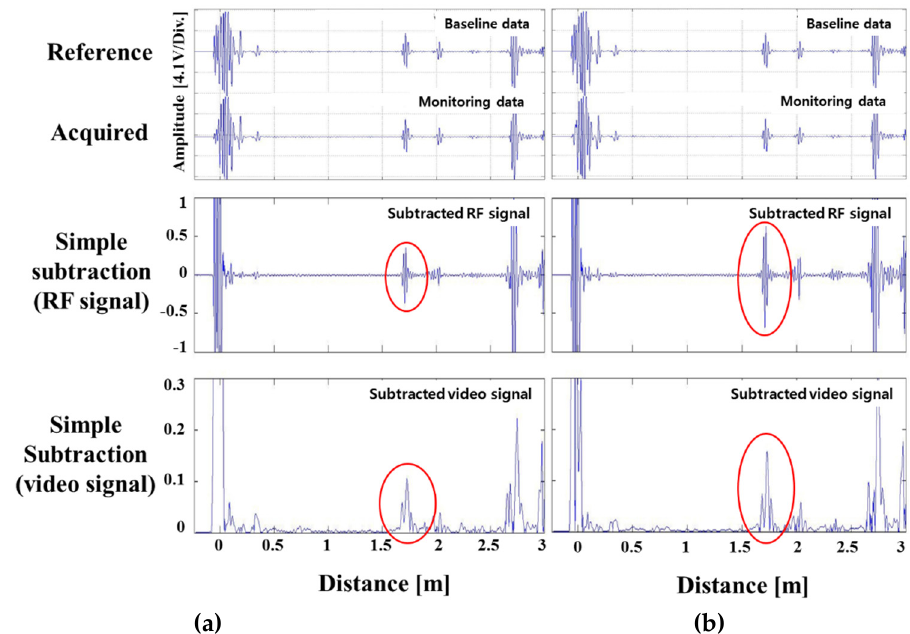
Figure 10. Signals of surface corrosion with various depths in a pipe weld: ( a ): defect ratio 2.55%, ( b ): defect ratio 3.46%.